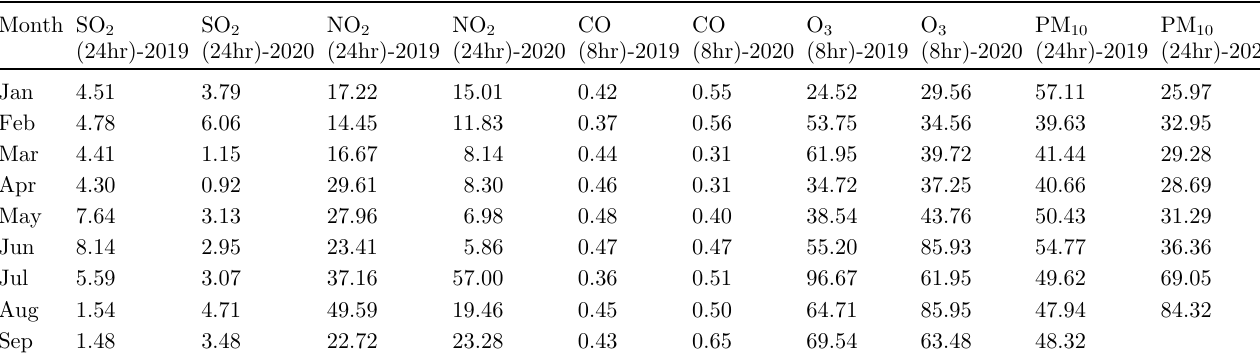
Table 2. List of the selected environmental stations with the measured